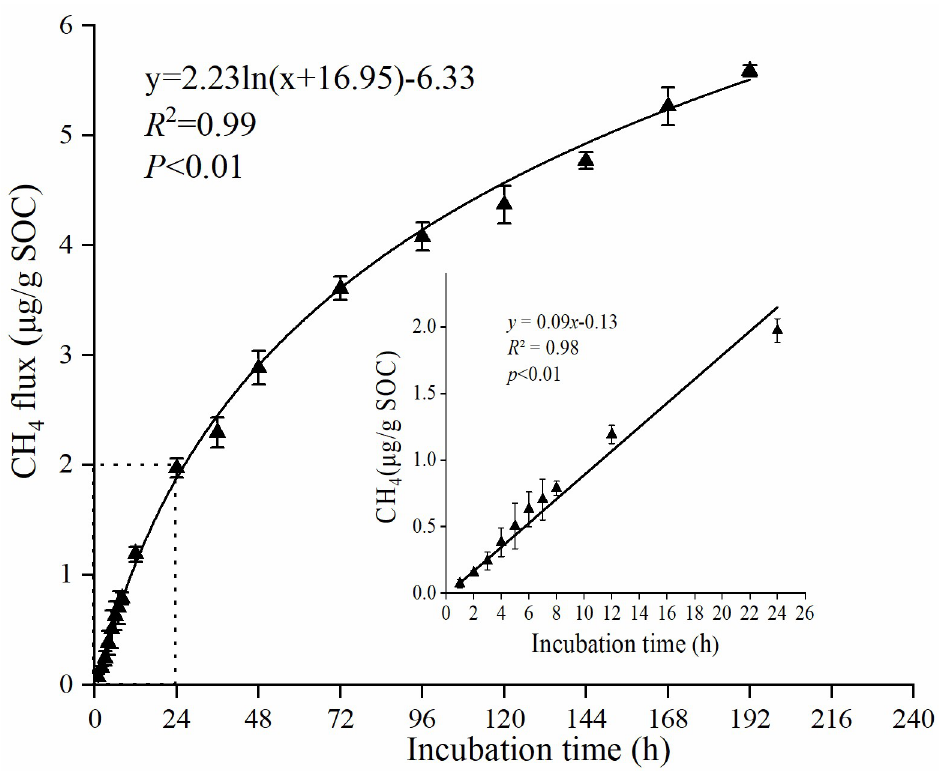
Fig 1. Emission flux of soil NM-CH 4 in aerobic environment at 70 ˚C with natural soil water contents in first 192 h.